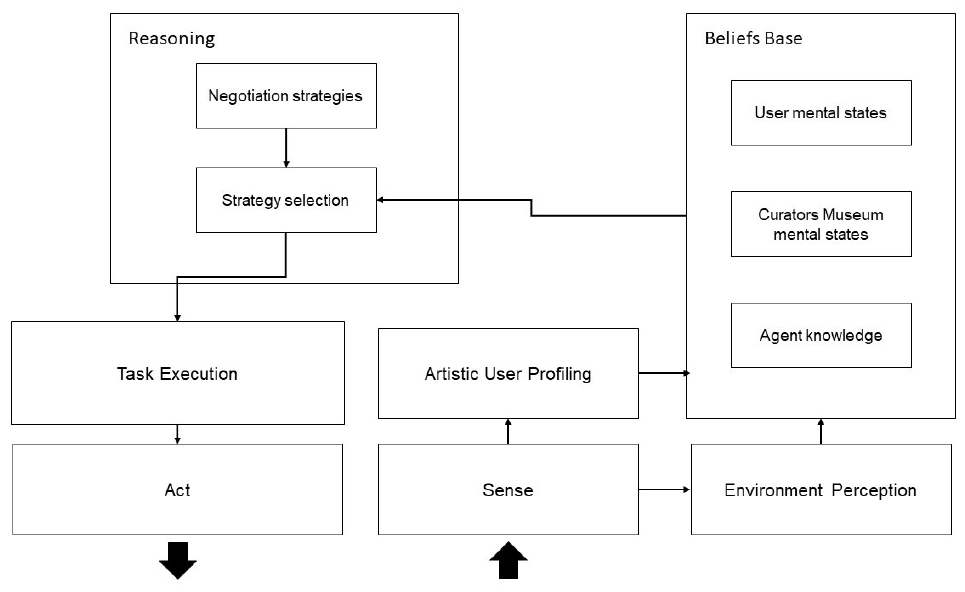
Figure 1. Perception-Reasoning-Action (PRA) cycle of the computational cognitive